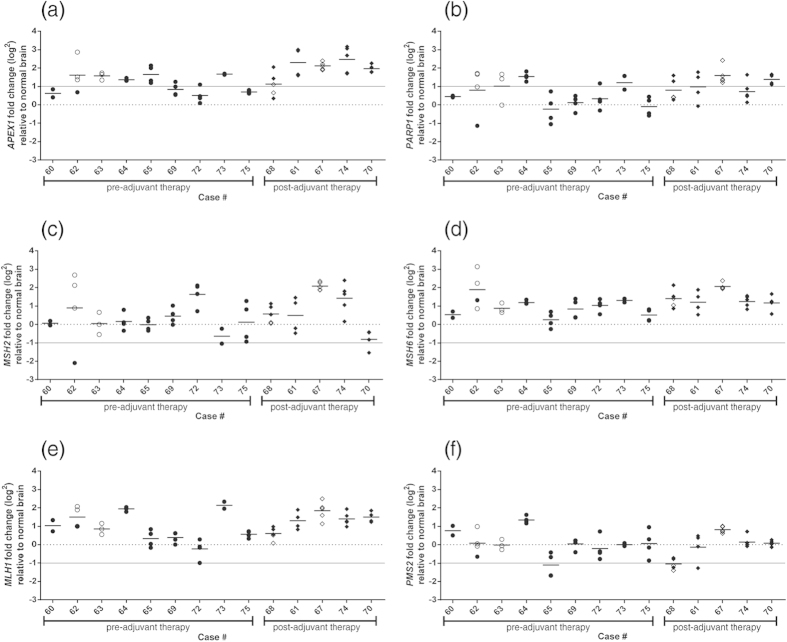
Gene expression analysis of MMR and BER pathways genes identifies both aberrant expression and intratumoral heterogeneity.The gene expression of Base Excision Repair (BER) genes (APEX1 and PARP1) and Mismatch Repair (MMR) genes (MSH6, MSH2, MLH1 and PMS2) was examined in tumor biopsies pre- and post-adjuvant therapy (indicated by circle and diamond symbols, respectively) relative to normal brain tissue (indicated by the broken line). Results were generated using Taqman assays and TBP as the reference for normalization. A 2-fold change in gene expression relative to normal brain is indicated by the solid grey line. Closed symbols indicate MGMT promoter unmethylated samples, open symbols indicate MGMT promoter methylated samples.